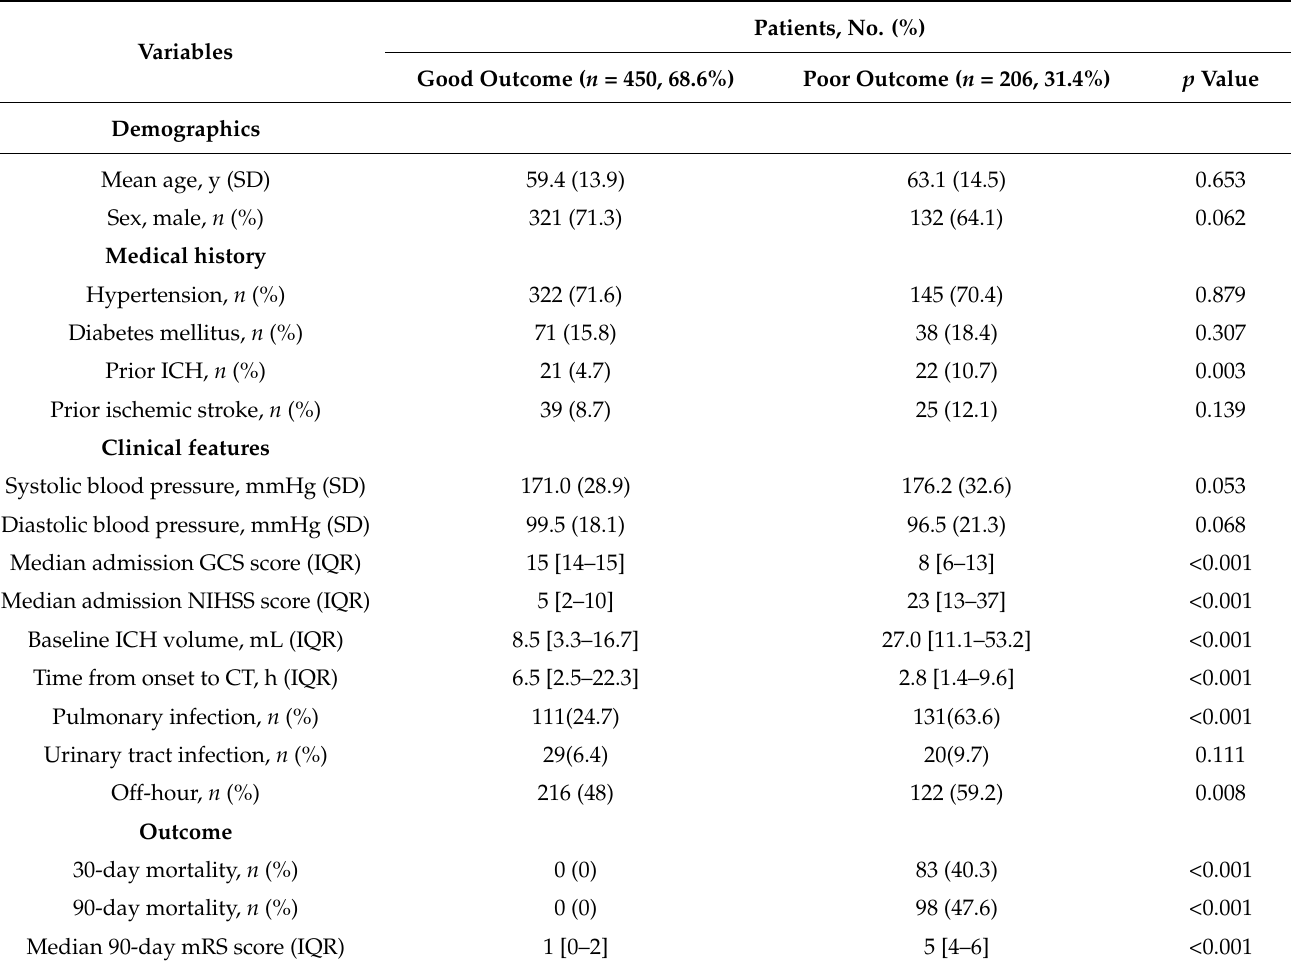
Table 2. Comparison of baseline demographic, clinical, and radiological characteristics between patients with and without poor